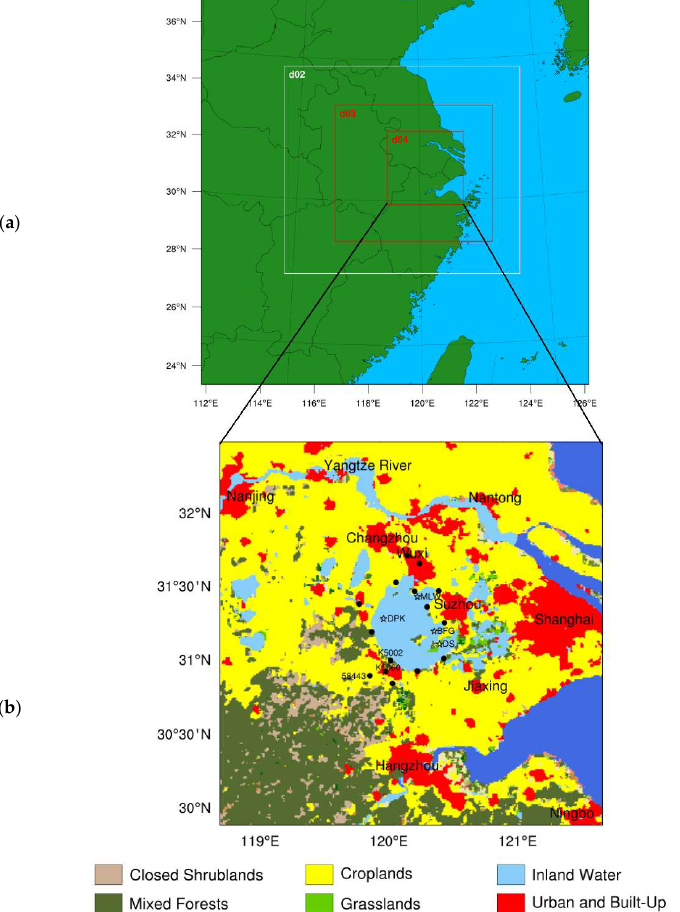
Figure 1. ( a ) is a map showing the study domain, ( b ) land use category of the third simulation domains. (meteorological observing stations; ∆ flux observing stations).